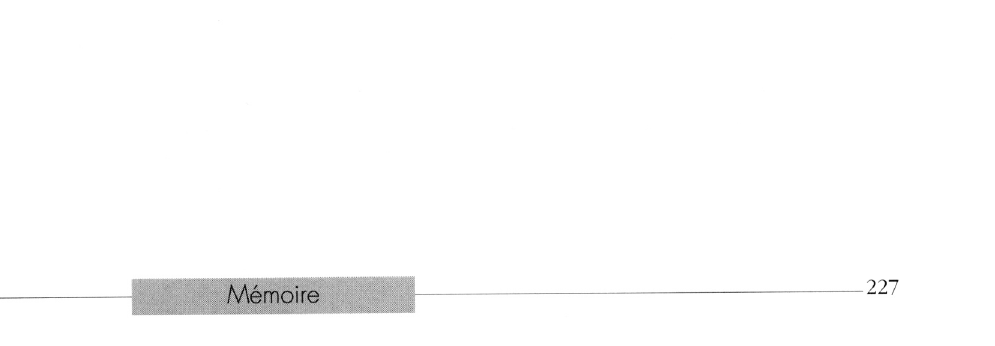
Fig. 3. - Pudica ginsburgi n. sp. A, male, head, apical view. B, male, anterior extremity, left lateral view. B’, male, detail of the excretory pore and the deirids, ventral view. C, female, ovejector and tail, right lateral view. D, female, invaginated tail, left lateral view. E, male, caudal bursa, ventral view. F-H, male, tips of the spicules. F, left spicule with the two alae forming a groove. G, right spicule. H, the two spicules in